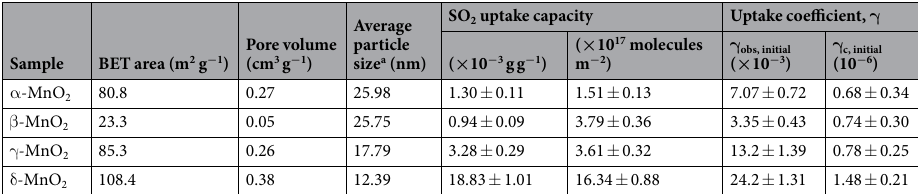
Table 1. Summary of physical properties and SO 2 uptake capacities and uptake coefficients for the heterogeneous reaction of SO 2 on manganese oxides. a Average size calculated using Scherrer equation derived from XRD